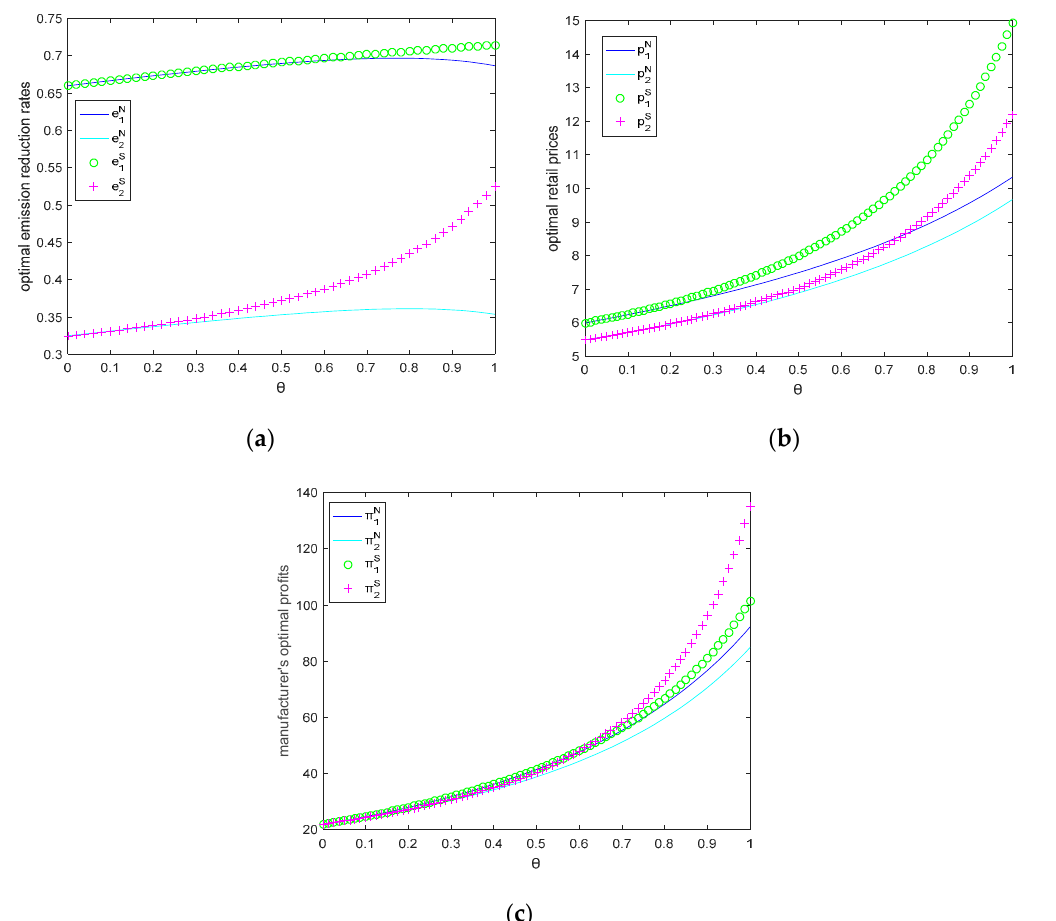
Figure 6. ( a ) Optimal emission reduction rates, ( b ) optimal retail prices and ( c ) manufacturer’s profits as a function of θ .